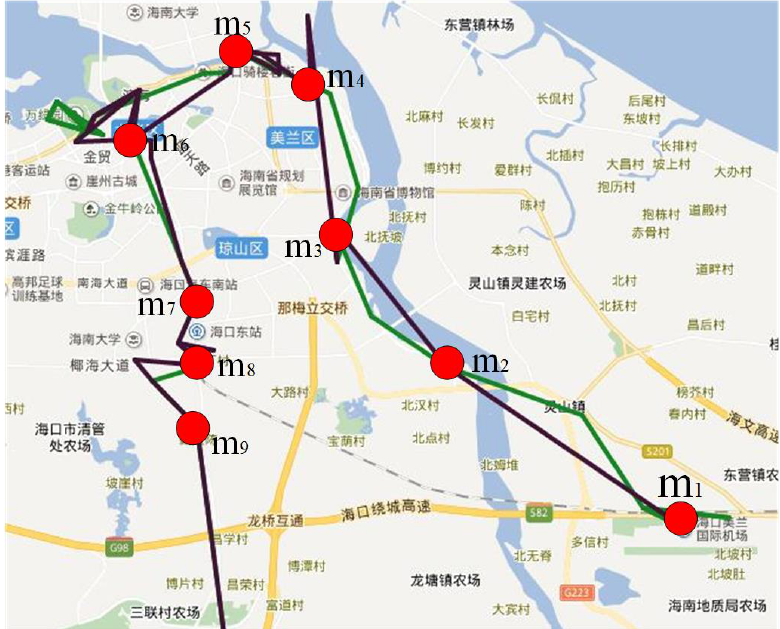
Figure 4. Two trajectories moving together with different sampling